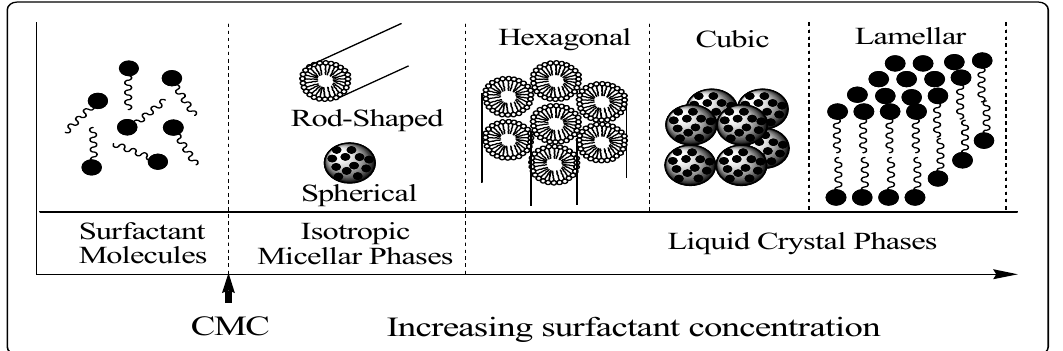
Figure 8. Phase sequence of surfactant-water binary system [37]. CMC = critical micellization